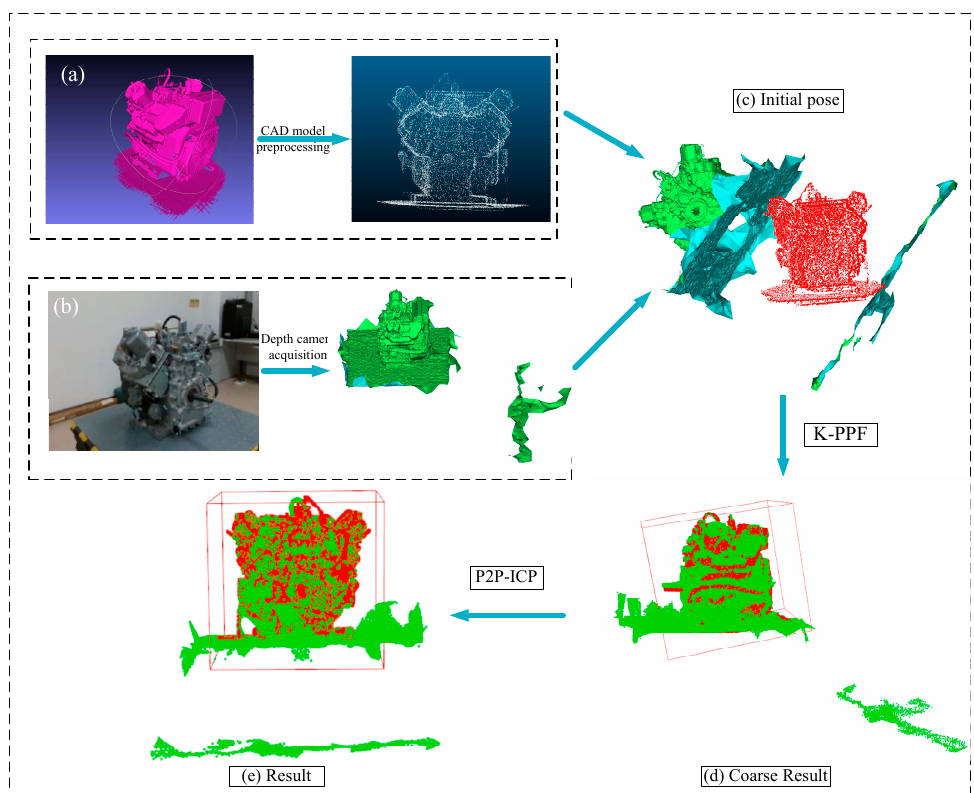
Figure 13. Real dataset recognition effect. ( a ) CAD model downsampling; ( b ) Scene point cloud collection; ( c ) Initial pose; ( d ) K-PPF coarse registration result; ( e ) Fine registration result.